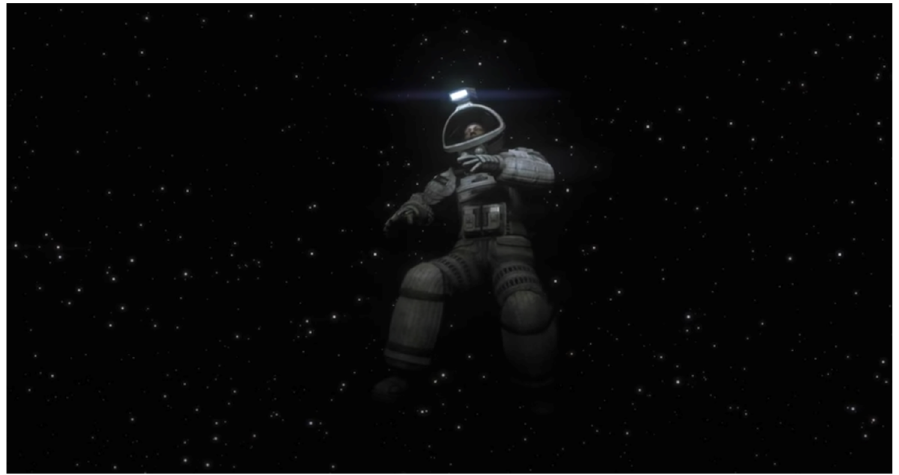
Figure 6. Amanda Ripley receding into empty space at the end of Alien: Isolation . Compelling stories and characters have difficulty thriving in a vacuum. If the de- velopers of Alien: Isolation had followed the blueprint provided by the film they were looking to for inspiration ( Alien ), they would have created more than just a realistic and sometimes terrifying game of “cat-and-mouse”. Instead, they would have developed rich characters, partly through respecting the distinct stages of the Hero’s Journey, and partly by fully capitalizing on the character relationships used to so successfully in Alien , Aliens , The Walking Dead , and The Last of Us . They would have created at least one character for the player to bond deeply with, protect, and perhaps even save. Then Amanda Ripley, and the people playing as her, might end the game feeling that sense of “closure” and emotional fulfillment they were seeking all